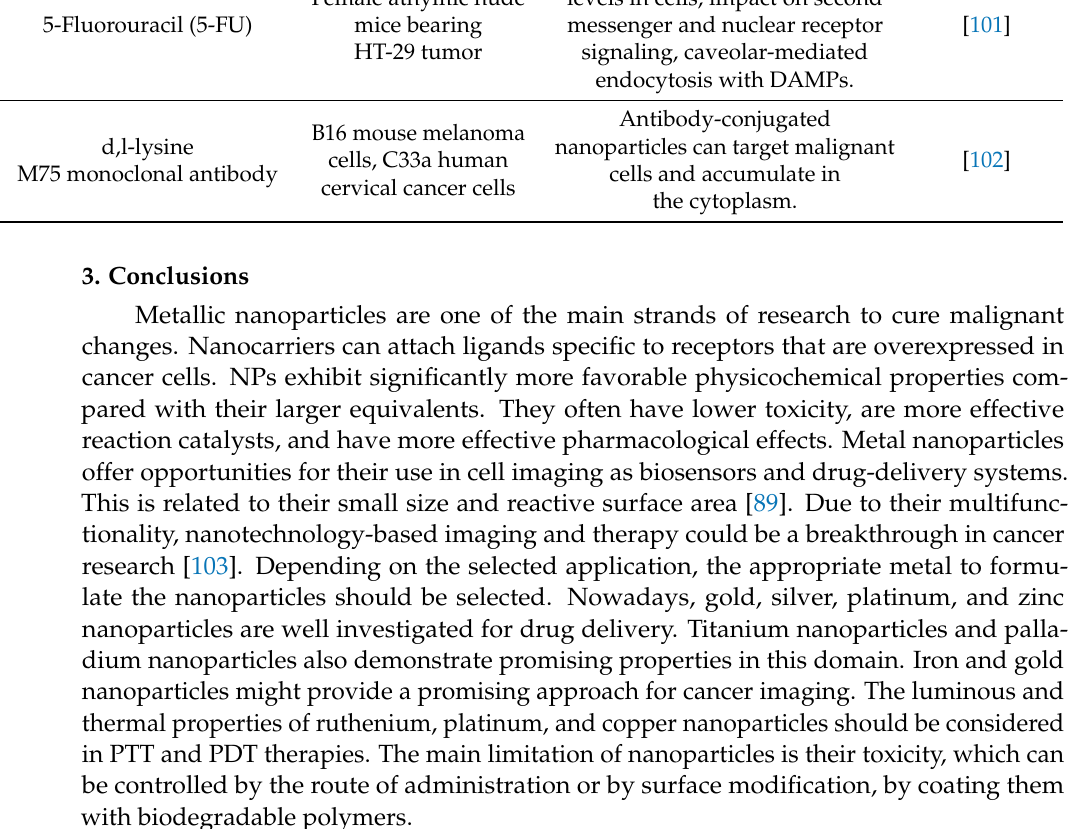
Redox-responsive properties resulted from a disulfide bond; the [95]